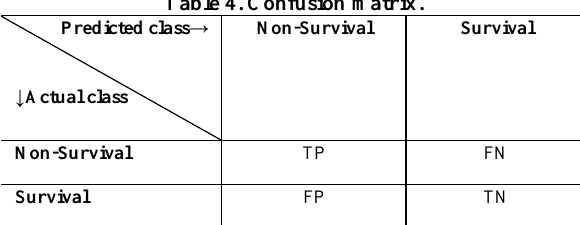
Table 4. Confusion matrix.